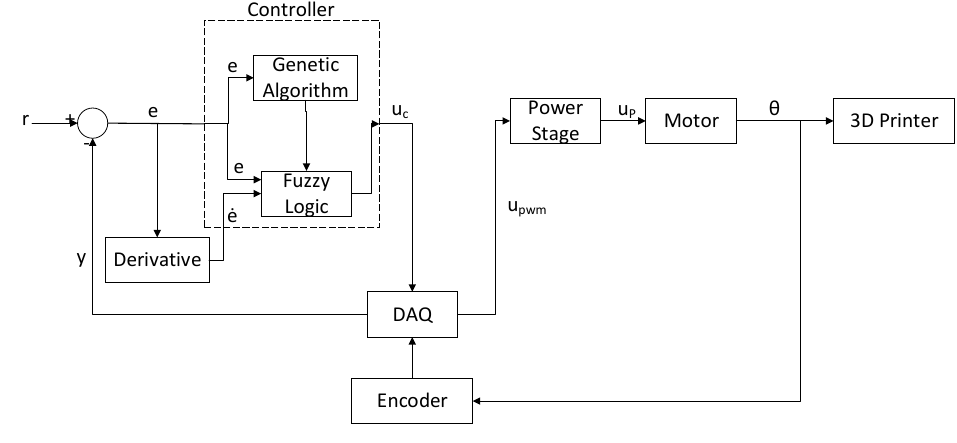
Figure 1. Diagram of the control loop designed for the project.